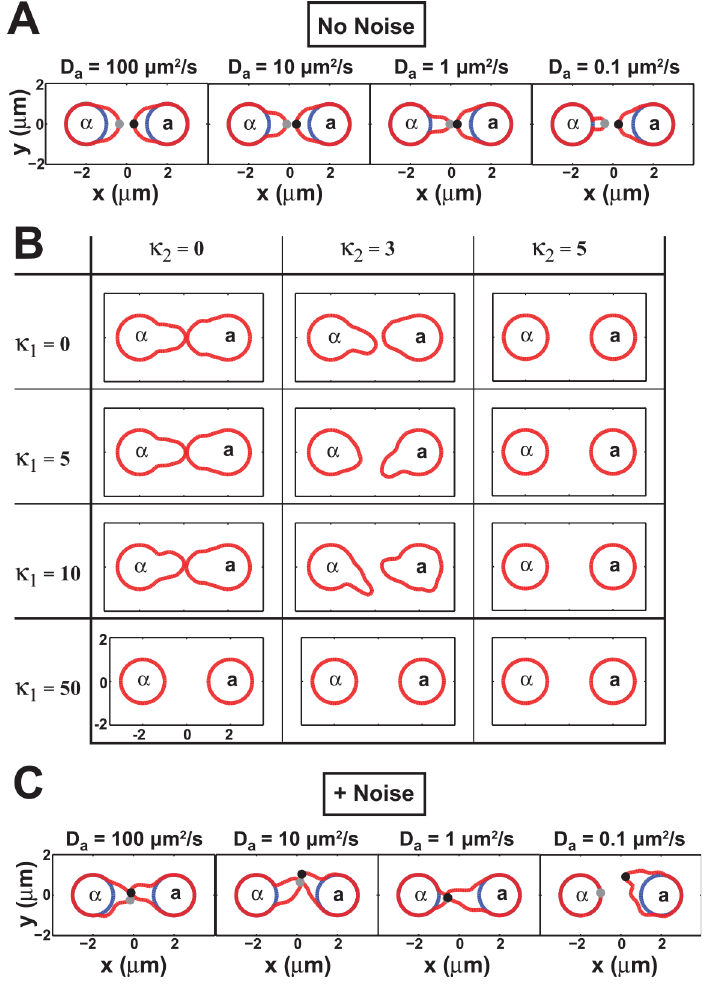
Fig 2. Effect of external and internal noise on yeast mating simulations. (A) Varying a -factor diffusion rates under no-noise simulation conditions. The diffusion constant for a -factor D a was set to 0.1, 1, 10, and 100 μ m 2 /s; the diffusion constant for α -factor was D α = 100 μ m 2 /s. The cell centers were separated by 4 μ m at the start. In all cases the cells were able to grow toward each other successfully. (B) External and internal noise disrupt mating. External ( κ 1 ) and internal ( κ 2 ) noises were added to the simulations using a range of values (0, 5, 10, 50 for κ 1 ; 0, 3, 5 for κ 2 ). 10 simulations were run for each combination, and an example simulation is shown for each specified pair of values ( κ 1 , κ 2 ). (C) Varying a -factor diffusion rates in the presence of noise. Simulations performed as in (A) except in the presence of noise ( κ 1 = 5, κ 2 = 3). All simulations produced mating except D a =